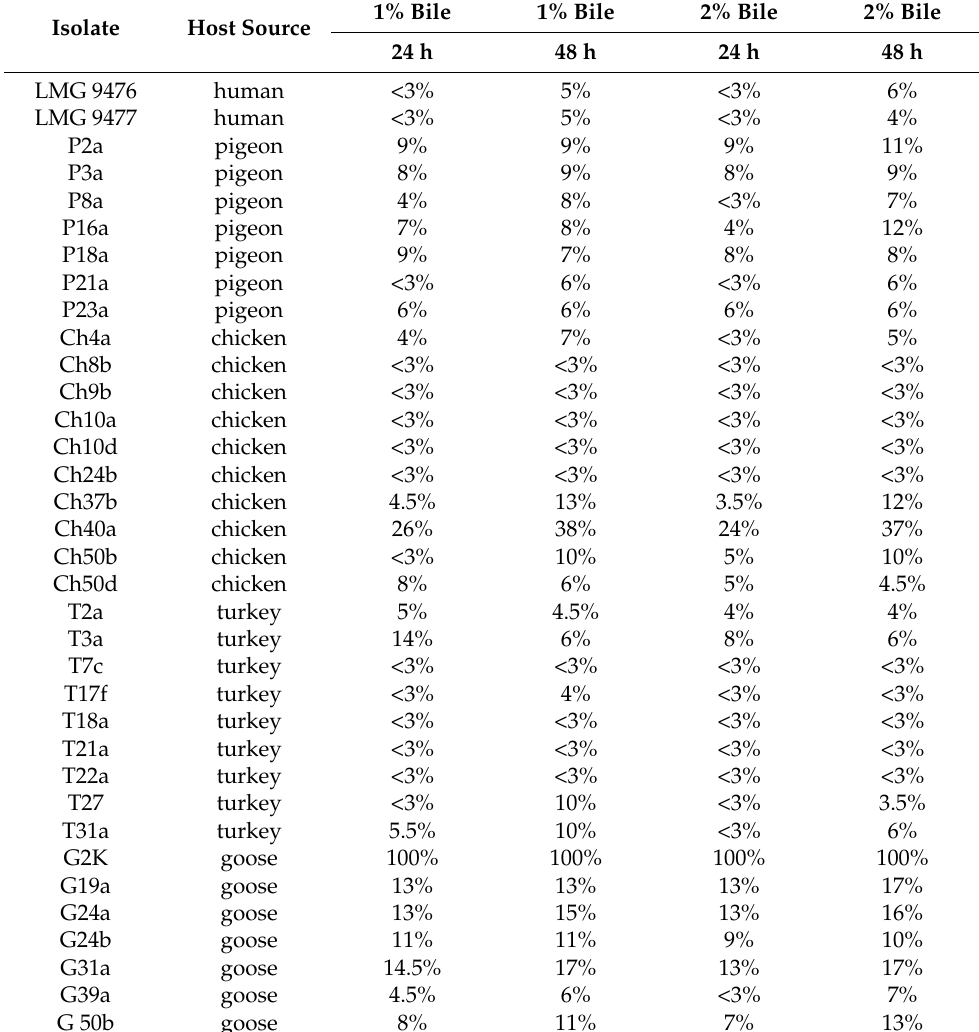
Table A4. The ability of avian L. salivarius strains to grow on MRS broth supplemented with 1% or 2% ox gall after 24 h and 48 h.